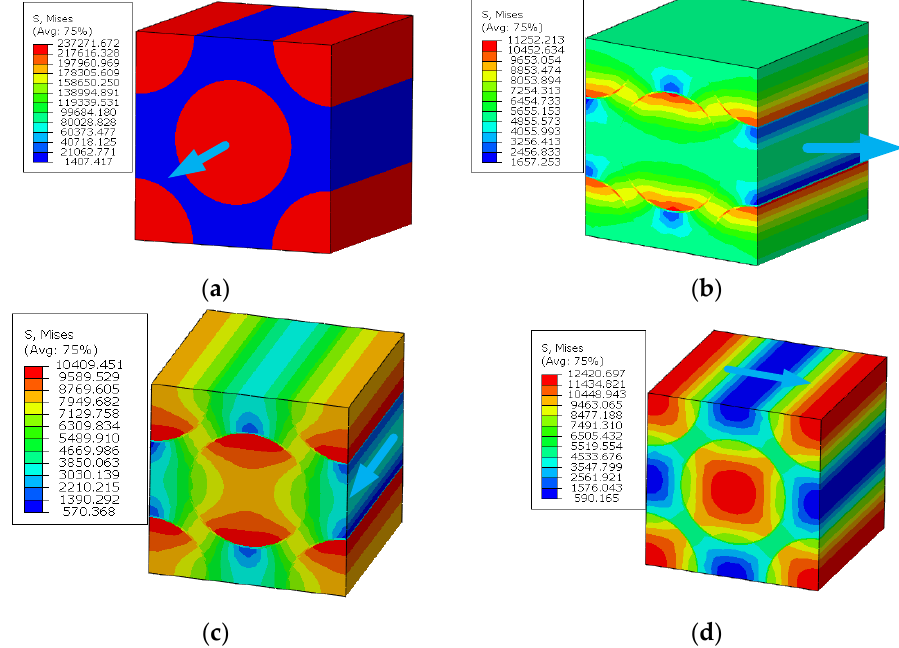
Figure 8. Stress distribution patterns for the fiber diamond distribution model. ( a ) longitudinal tensile loading; ( b ) transverse tensile loading; ( c ) longitudinal shear loading; ( d ) transverse shear loading.